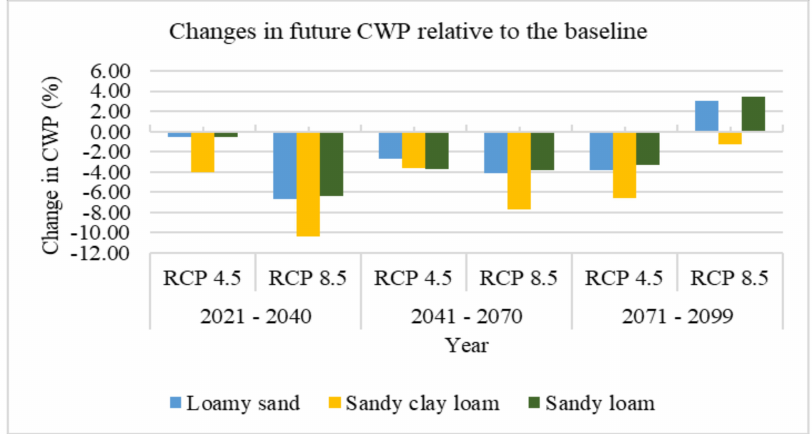
Figure 11. Temporal changes in future maize yields under RCPs 4.5 and 8.5 (2021–2099) relative to the baseline (1986–2015).